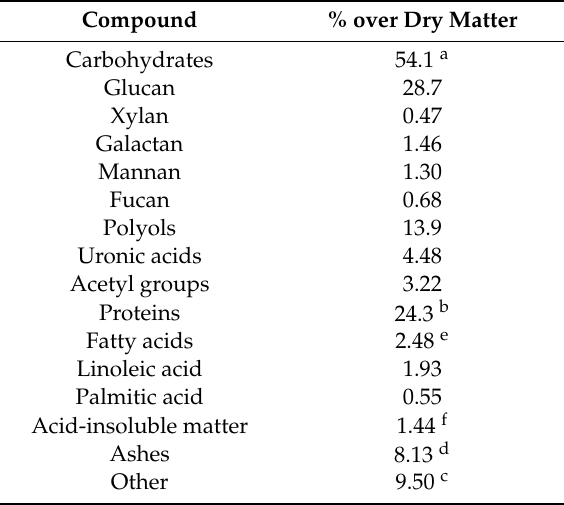
Table 1. Composition of Lentinula edodes in mass percentage over dry matter.